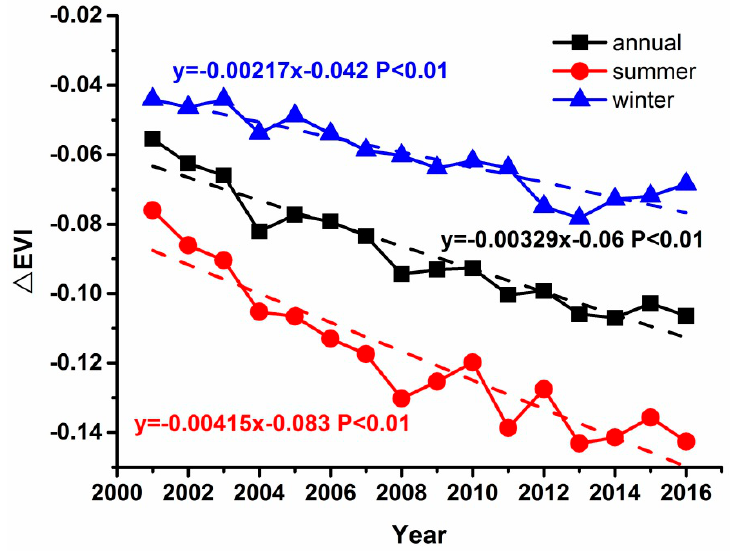
Figure 4 . The temporal trends of ∆ EVI averaged for 10 cities during 2001–2016. Figure 4. The temporal trends of ∆ EVI averaged for 10 cities during